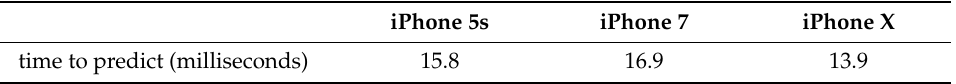
Table 7. Time consumption for network prediction across di ff erent smartphone models.